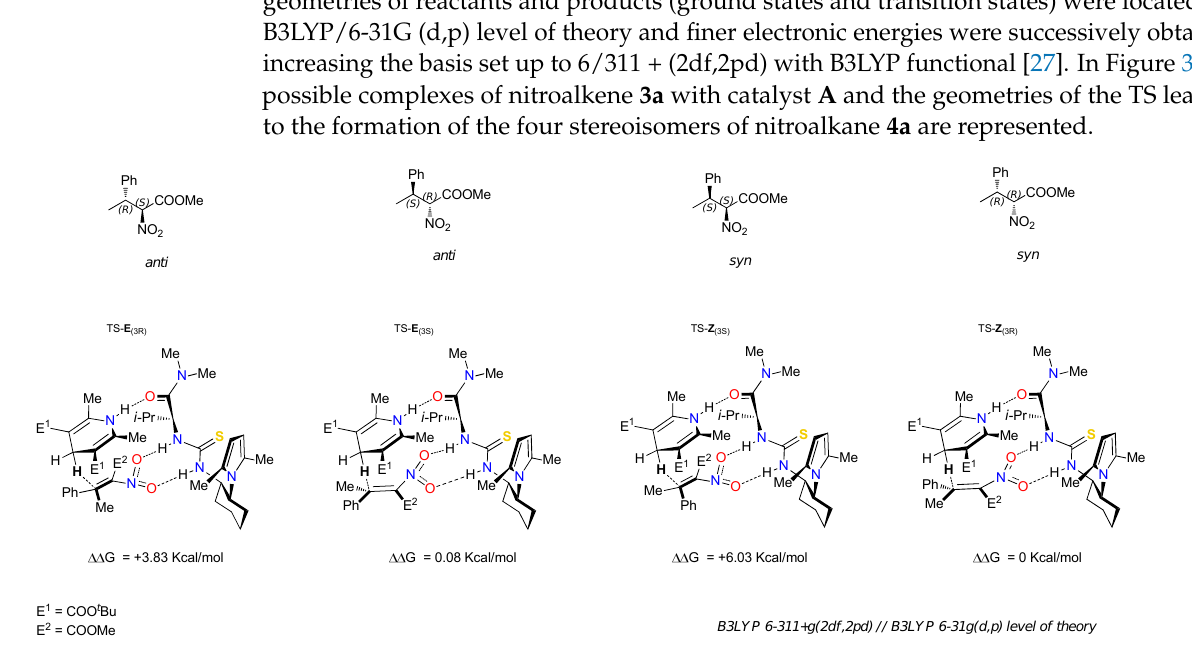
Figure 3. The four possible TS geometries for nitroalkene 3a complexes with catalyst A.